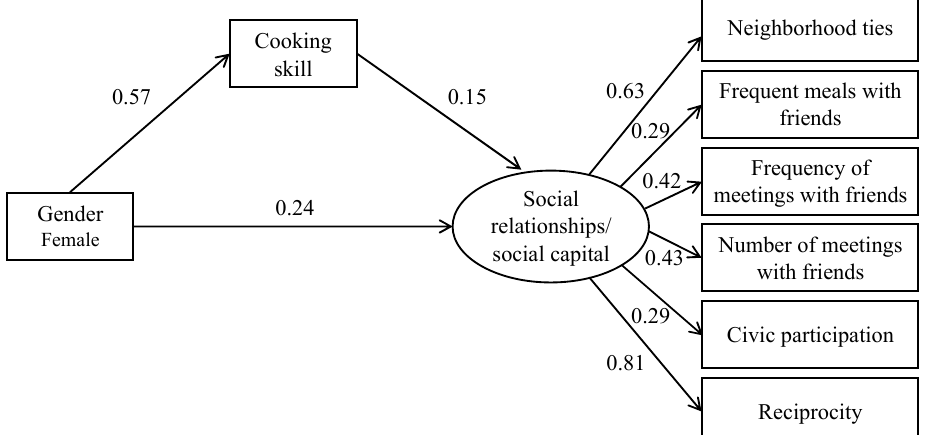
Figure 1. Path model of associations of gender with social relationships and social capital ( n = 15,207). Path coefficients were standardized. All path coefficients were statistically significant ( p < 0.05). Likelihood-ratio test of the model, chi-square = 208.4, p < 0.001; Comparative fit index = 0.991; Root Mean Square Error of Approximation = 0.03; Standardized Root Mean Square Residual = 0.016.